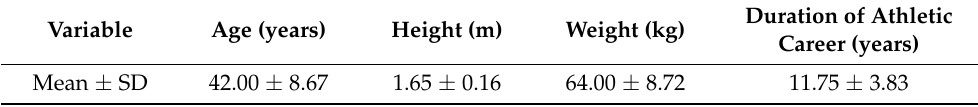
Table 1. The physical composition of the participants.